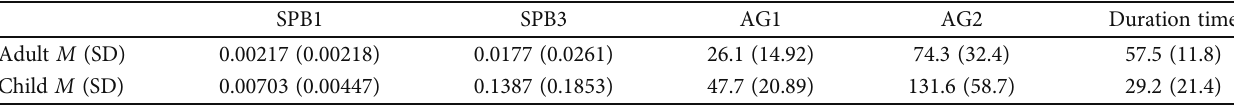
Table 2: Means and standard deviations for the selected